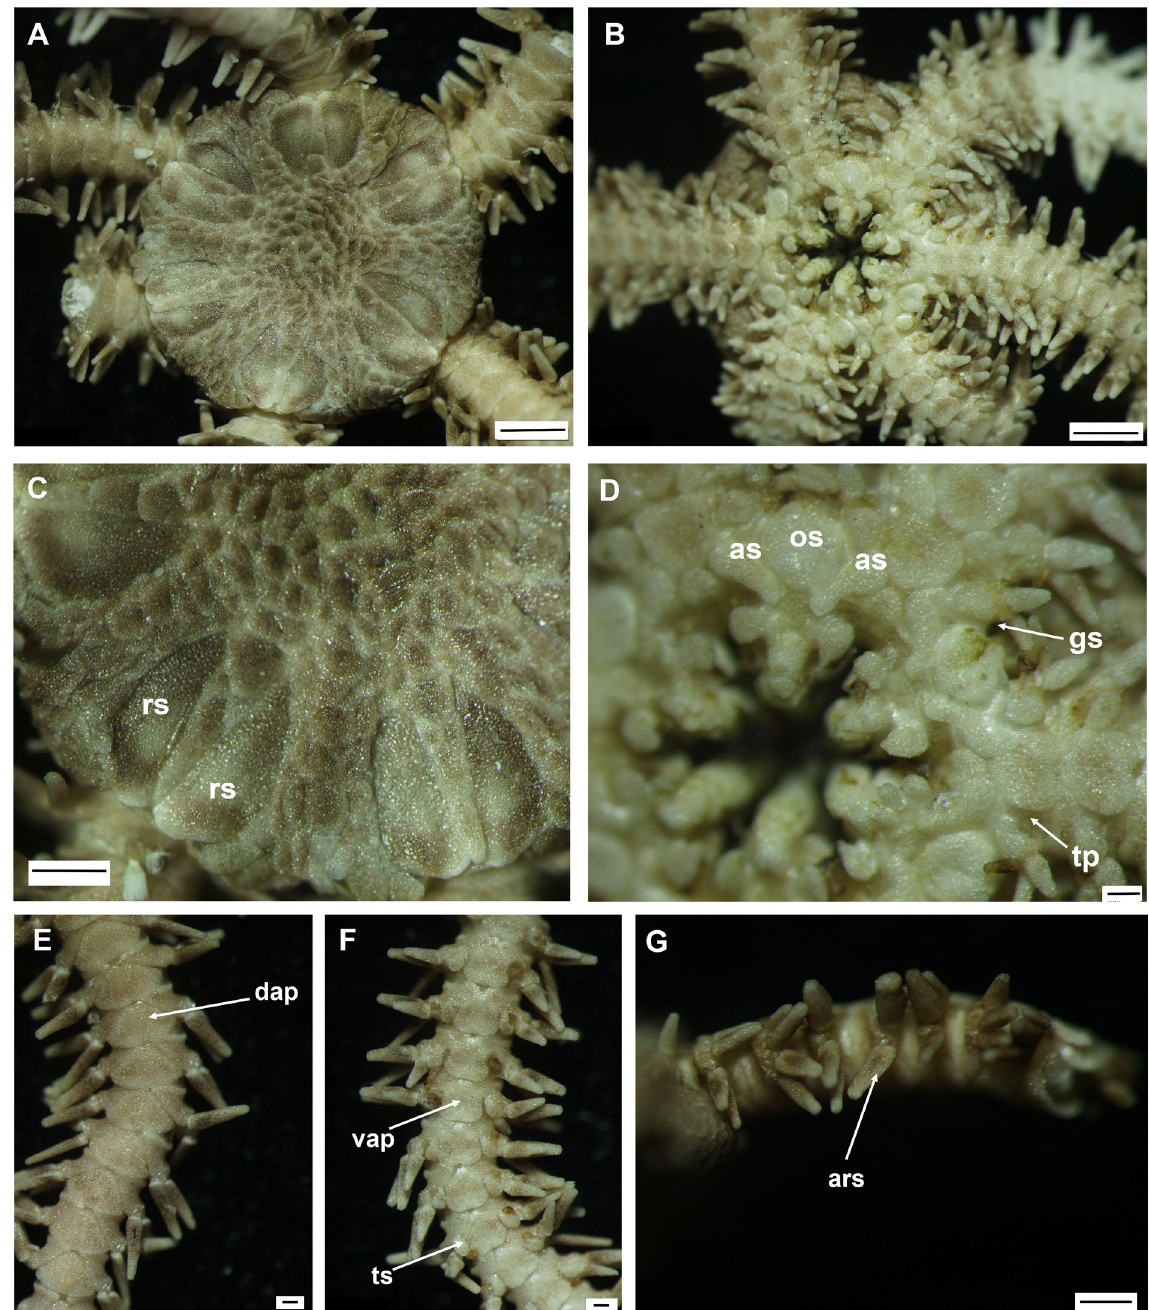
Fig. 38. Ophiactis profundi Lütken & Mortensen, 1889 (IDSSE EEB-SW0017). A . Dorsal disc. B . Ventral disc. C . Radial shields. D . Oral frame. E . Dorsal arm. F . Ventral arm. G . Lateral arm. Abbreviations: ars = arm spine; as = adoral shield; dap = dorsal arm plate; gs = genital slit; os = oral shield; rs = radial shield; tp = tentacle pore; ts = tentacle scale; vap = ventral arm plate. Scale bars: A–B = 1 mm; C, G = 500 µm; D–F = 200